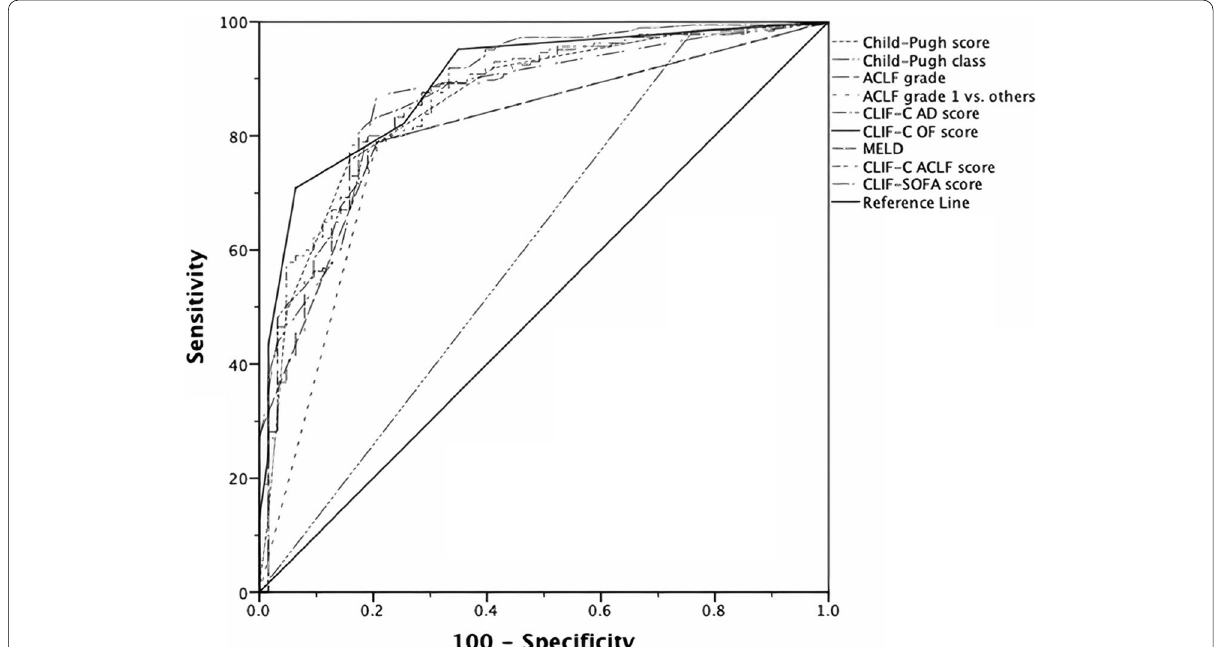
Fig. 2 ROC curves of the studied scores in prediction of in‑hospital mortality. Legend: ACLF, acute‑on‑chronic liver failure; AD, acute decompensation; CI, confidence interval; CLIF‑C, chronic liver failure consortium; MELD, model for end‑stage liver disease; OF, organ failure; SOFA, Sequential Organ Failure Assessment